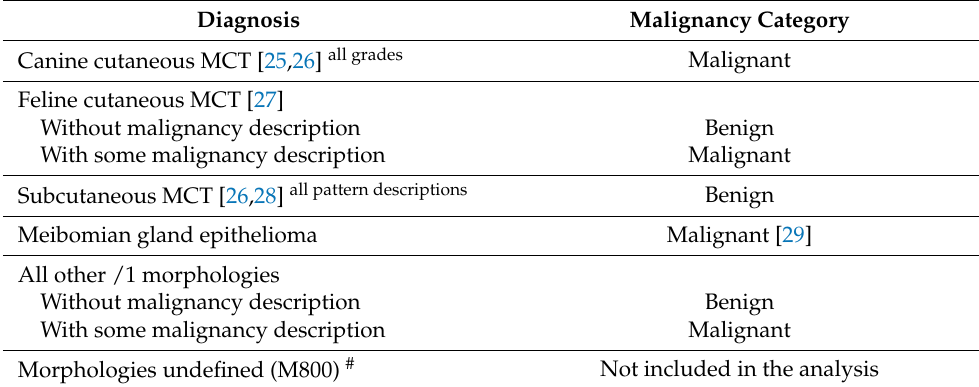
Table 1. Criteria utilized to assess the malignancy of tumors with behavior code /1. Diagnosis Malignancy Category Canine cutaneous MCT [25,26] all grades Malignant Feline cutaneous MCT [27] Without malignancy description Benign With some malignancy description Malignant Subcutaneous MCT [26,28] all pattern descriptions Benign Meibomian gland epithelioma Malignant [29] All other /1 morphologies Without malignancy description Benign With some malignancy description Malignant Morphologies undefined (M800) # Not included in the